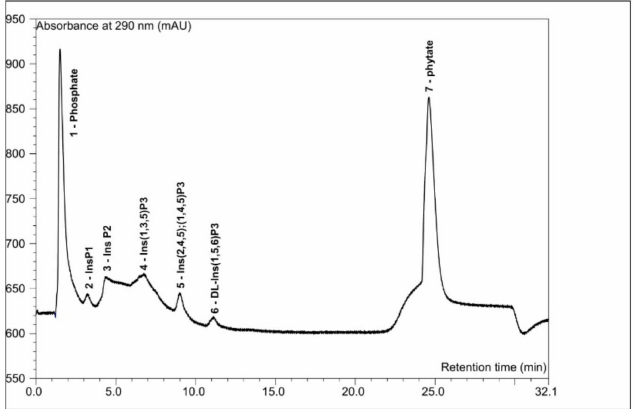
Figure 2. Sample chromatogram from the profile in the control buckwheat wort analyzed by HPAEC–UV / Vis